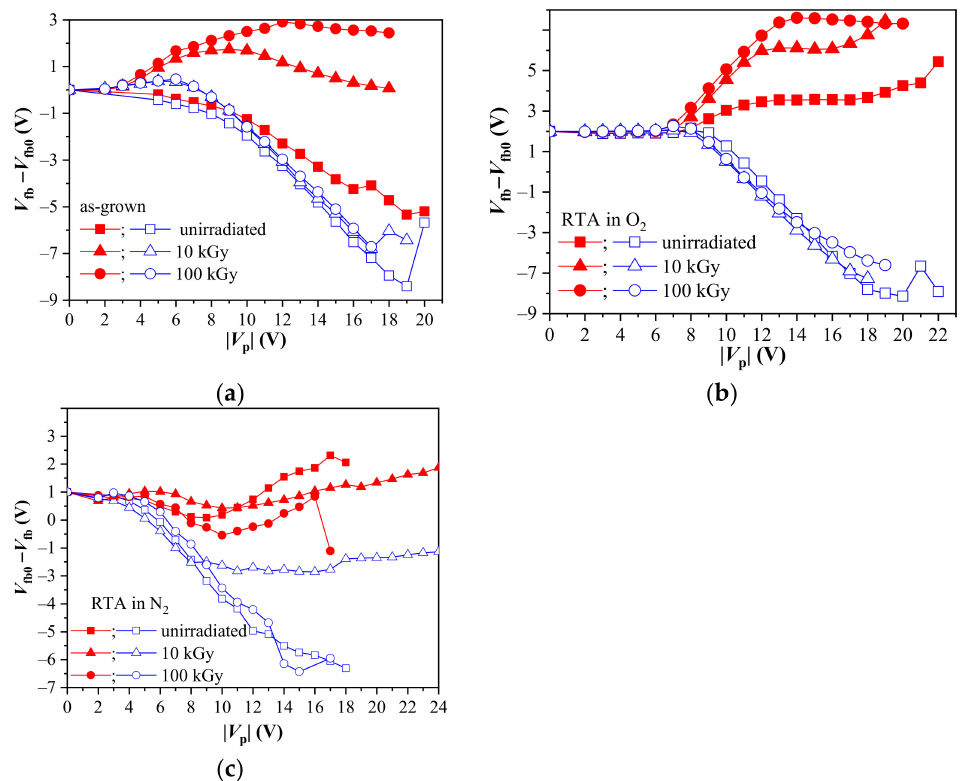
Figure 3. The evolution of the flat-band voltage changes on applying voltage pulses with different V p , before and after irradiation: ( a ) as-grown; ( b ) O 2 treated and ( c ) N 2 treated stacks, respectively. Solid symbols depicts values after + V p and hollow after − V p